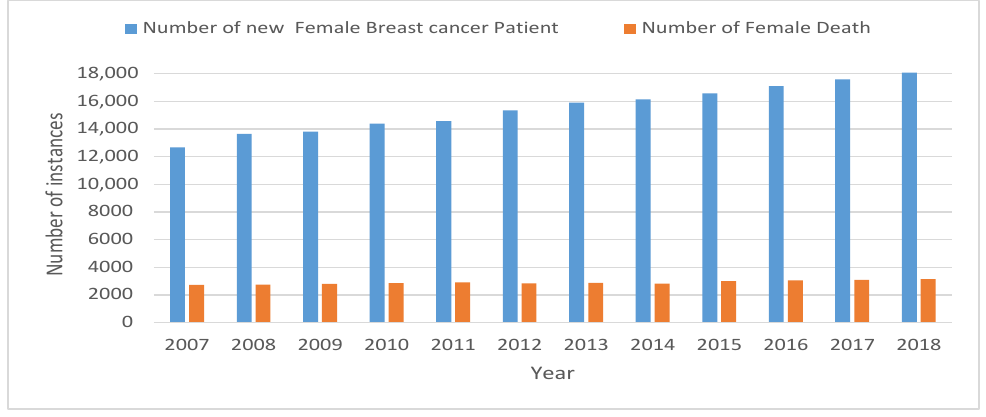
Figure 1. New cases of breast cancer for women and number of women dying in the last twelve